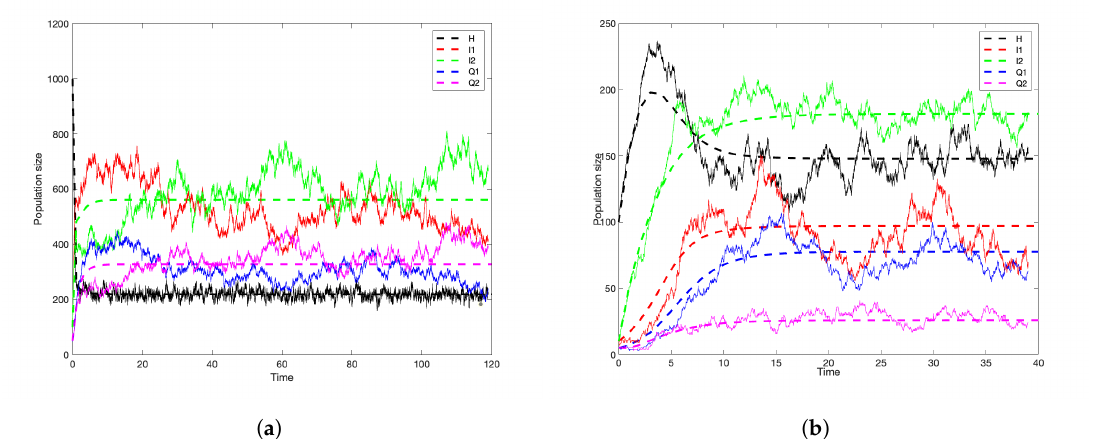
Figure 1. Numerical simulations of the deterministic model (1) compared with stochastic simulation using Gillespie’s algorithm. In ( a ), the initial population size is H = 1000, I 1 = 100, I 2 = 100, Q 1 = Q 2 = 50. The values of the parameters are symmetrical; β 1 = β 2 = 0.005, Λ = 1000, d = 0.5, ν 1 = ν 2 = 0.3, γ 1 = γ 2 = 0.003, (cid:101) 1 = (cid:101) 2 = 0.6, ζ 1 = ζ 2 = 0.7, ρ 1 = ρ 2 = 0.7. While in ( b ), the initial population size is H = 100, I 1 = 10, I 2 = 10, Q 1 = Q 2 = 5. The values of the parameters are asymmetrical; β 1 = 0.005, β 2 = 0.0005, Λ = 100, d = 0.3, ν 1 = 0.3, ν 2 = 0.003, γ 1 = γ 2 = 0.003, (cid:101) 1 = 10, (cid:101) 2 = 50, ζ 1 = 0.2, ζ 2 = 0.4, ρ 1 = 0.4, ρ 2 =